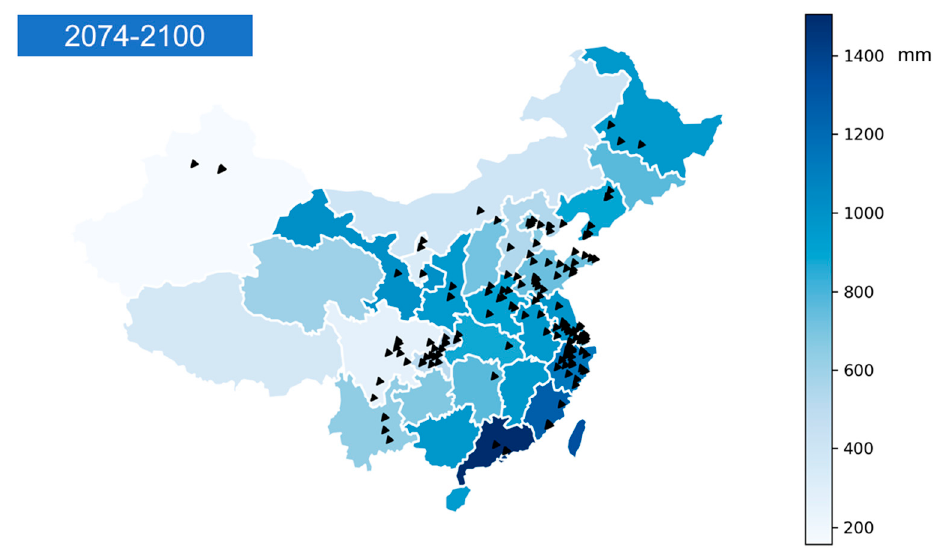
Figure A8. Annual average precipitation levels in long-term future (2074–2100), and locations of wastewater treatment plants included in the sample.